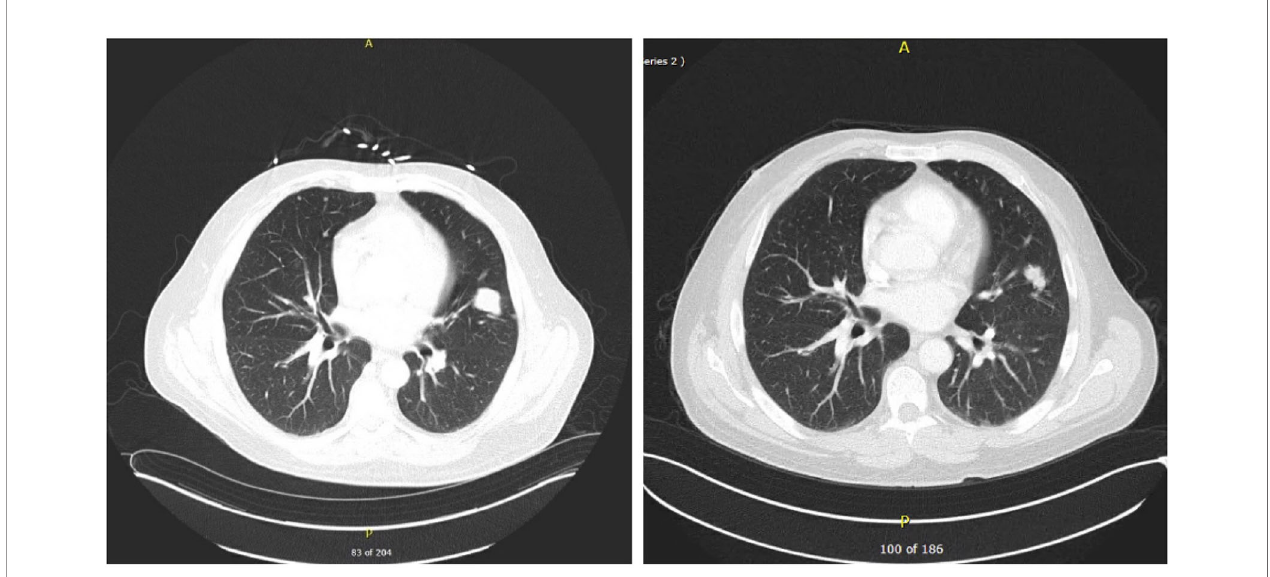
FIGURE 3 | CT scan of chest showing dominant lingular mass concerning for primary lung cancer or metastatic lesion. Multiple bilateral small pulmonary nodules and T3 vertebral body destructive lesion seen concerning for metastatic disease on day 1 on the left vs on day 104 on the right showing decrease in sizes and numbers of pulmonary nodules suggestive of favorable treatment